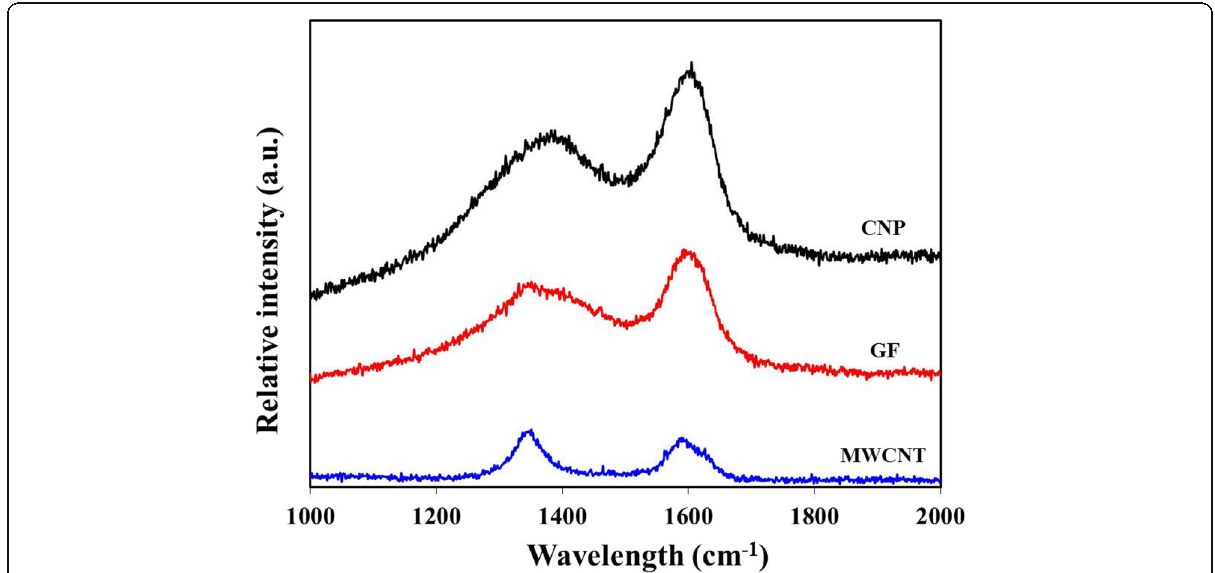
Fig. 2 Raman spectra of CNPs, MWCNTs, and